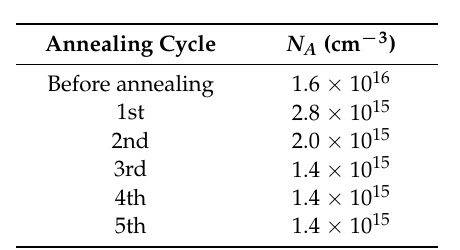
Table 1. Variation of the dopant concentration ( N A ) for annealing cycle in the ITO/PI/P3HT/Au MIS capacitor.